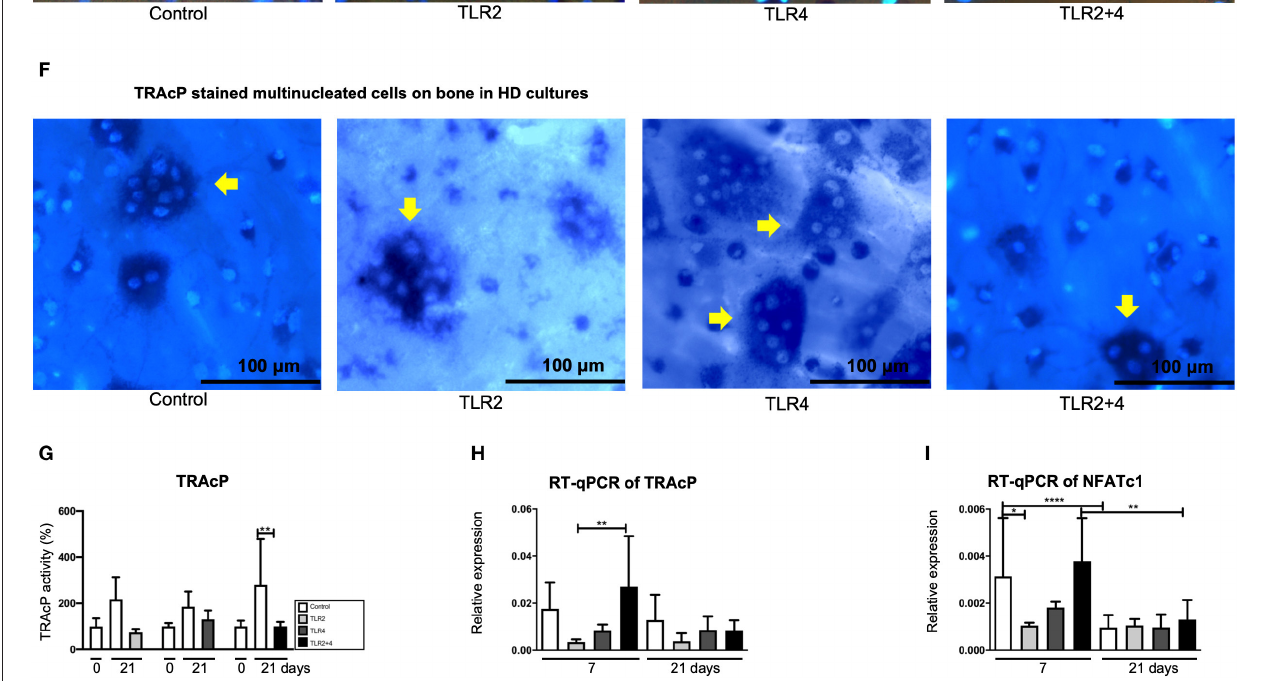
FIGURE 2 | TLR2 agonist decreases the number of multinucleated cells in GF-PBMC co-cultures and PBMC high-density cultures. The number of multinucleated cells is presented in (A–D) . The concertation of the agonists was 10ng/mL. Osteoclast formation is particularly decreased in the presence of TLR2 (light gray bars, A,B ) and TLR2 + 4 agonists (black bars, A ). (C) Multinucleated cells were counted on bone slices but they were in very low numbers. (D) In high density cultures, multinucleated cells were a more common finding but without any difference between the conditions. Cells were stained for tartrate-resistant acid phosphatase (TRAcP, purple) and counterstained with DAPI (blue), in order to detect the multinucleated cells (depicted with yellow arrows); on plastic (E) and on bone (F) . All micrographs are representatives for three independent experiments with six different GF sources. Scale bar represents 100 µ m. (G) TRAcP enzyme activity was measured by three different conditions, each with separate 0 days and a 21 days control samples. TRAcP enzyme activity is significantly decreased at day 21 at the TLR2 + 4 condition in comparison with the control. (H,I) Real-time quantitative PCR was performed for the genes of TRAcP and NFATc1). n = 6 GF cultures per condition in duplicates, average results ± SD are shown. For the HD cultures n = 4. Significant results for (A–D) and (G–I) are shown (black bars). * p < 0.05, ** p < 0.01, *** p < 0.005, **** p < 0.001. a High density culture.